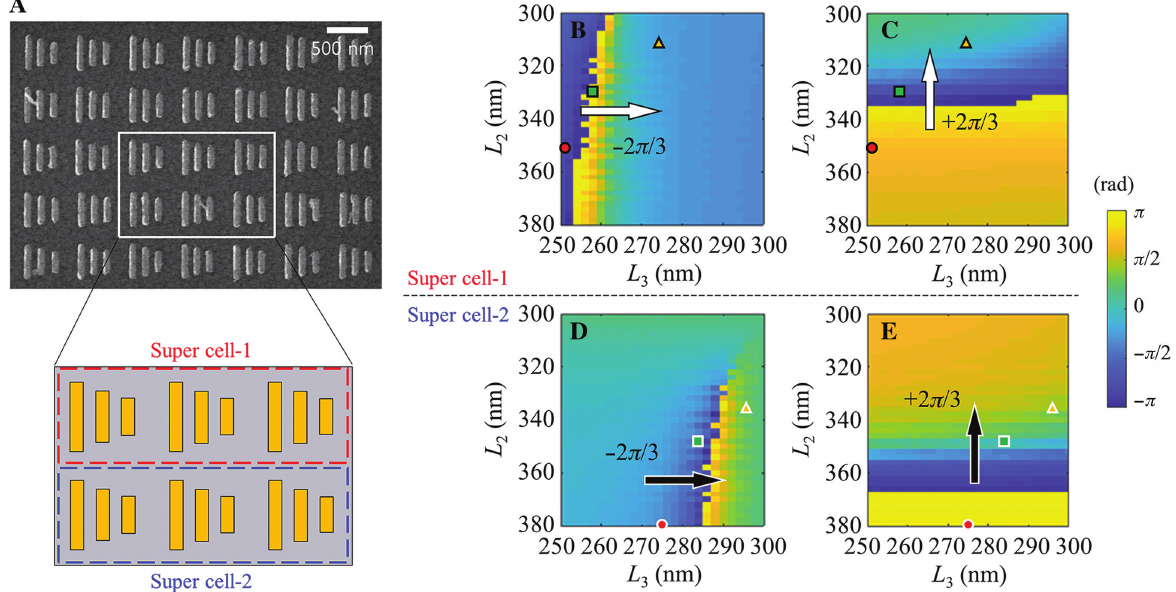
Figure 2: Design of gradient metasurface for optical demultiplexer. (A) Schematic illustration of a gradient metasurface for the function of optical demultiplexer. (B–E) Numerically calculated phase values to design gradient metasurface according to the change of L and L . Phase maps of target wavelengths (B) 1344 nm and (C) 1610 nm for 2 3 supercell-1 and (D) 1440 nm and (E) 1700 nm for supercell-2. Each marker (circles, squares, and triangles) and an arrow indicate the selected geometric parameters of the length and gradient phase